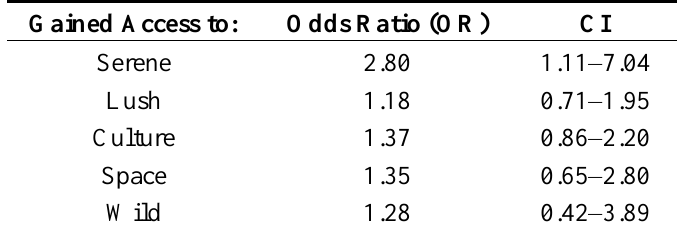
Table 3. Odds ratios for improved mental health (remedy) by gained access to a nature quality.